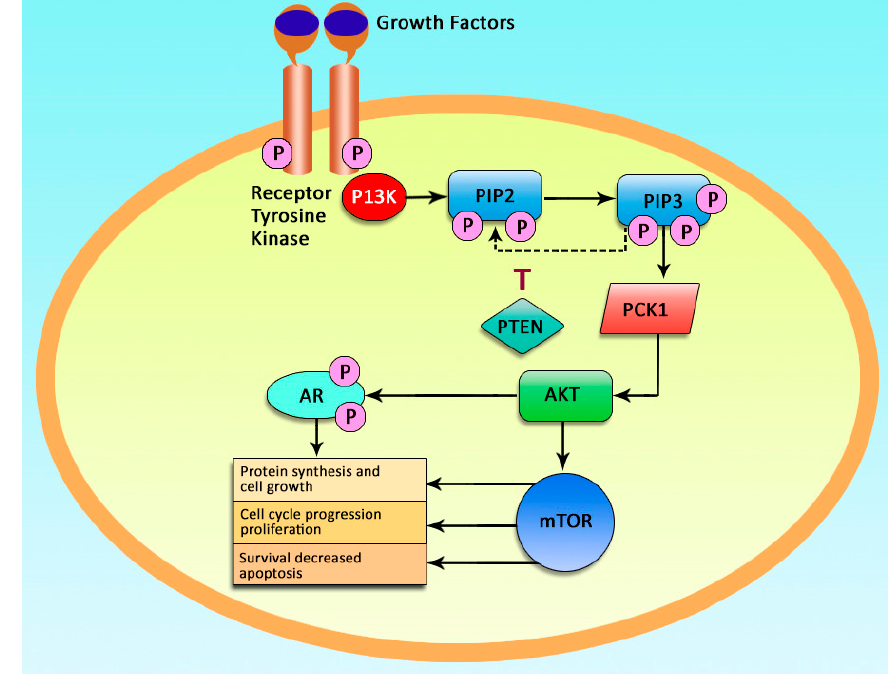
Figure 1. The phosphatidylinositol 3-kinase (PI3K)/AKT/mTOR pathway. Main signaling pathway initiated by growth factors that activate tyrosine kinase to initiate a series of downstream reactions that trigger P13K to generate second messenger (PIP3). PIP3 activates downstream signaling cascade important in cell proliferation, migration, transport, and survival.